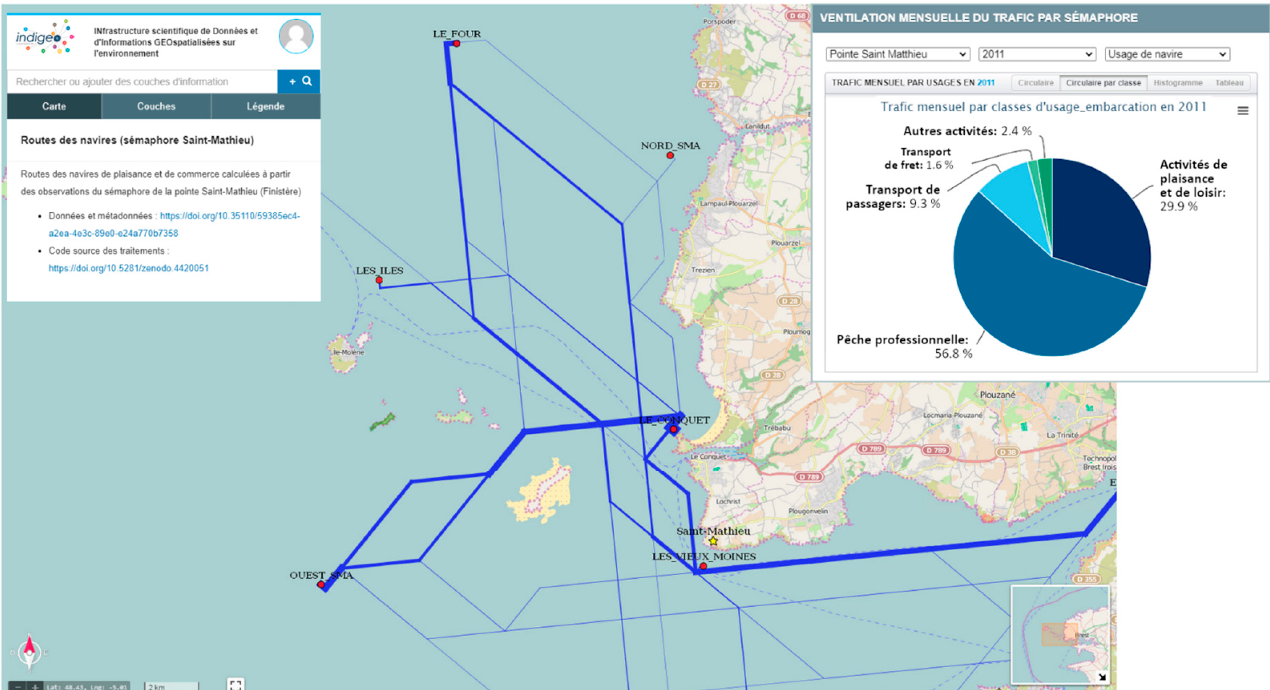
Figure 11. Visualization of the output data stored in INDIGEO (https://portail.indigeo.fr/geocms/projects/cartahu, accessed the 03/03/2021).